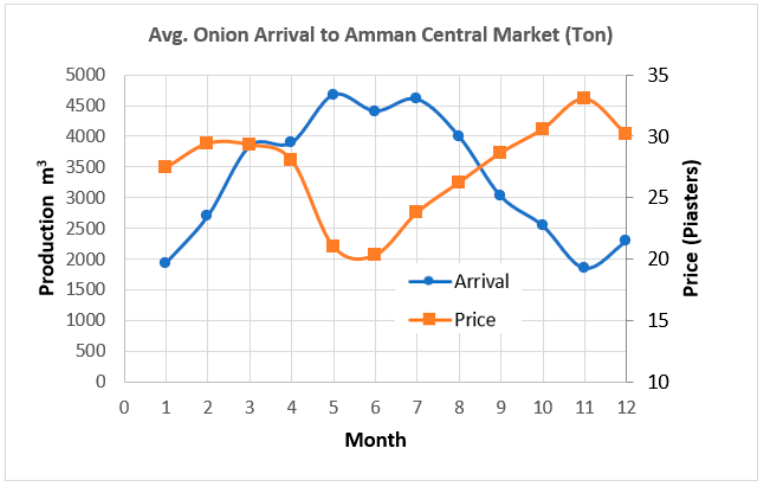
Figure 6. Average onion production and prices in Amman central market throughout the year.